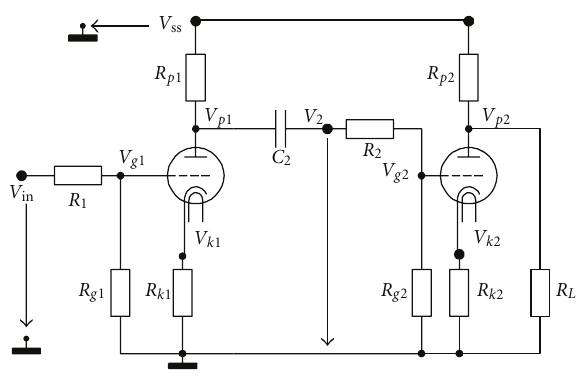
Figure 4: Circuit schematic of the second block of the guitar